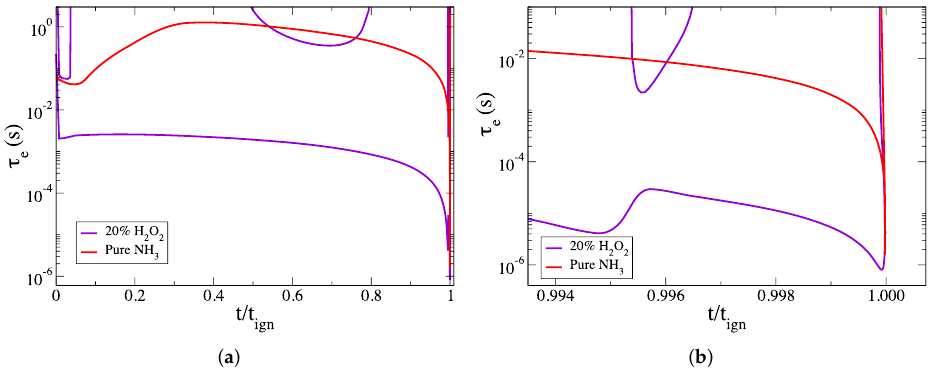
Figure 7. The developing explosive time scales of the cases of 20% H 2 O 2 addition (purple), compared to the ones of the case of pure ammonia (red), versus the scaled time: ( a ) the full explosive stage, ( b ) the final part of the explosive